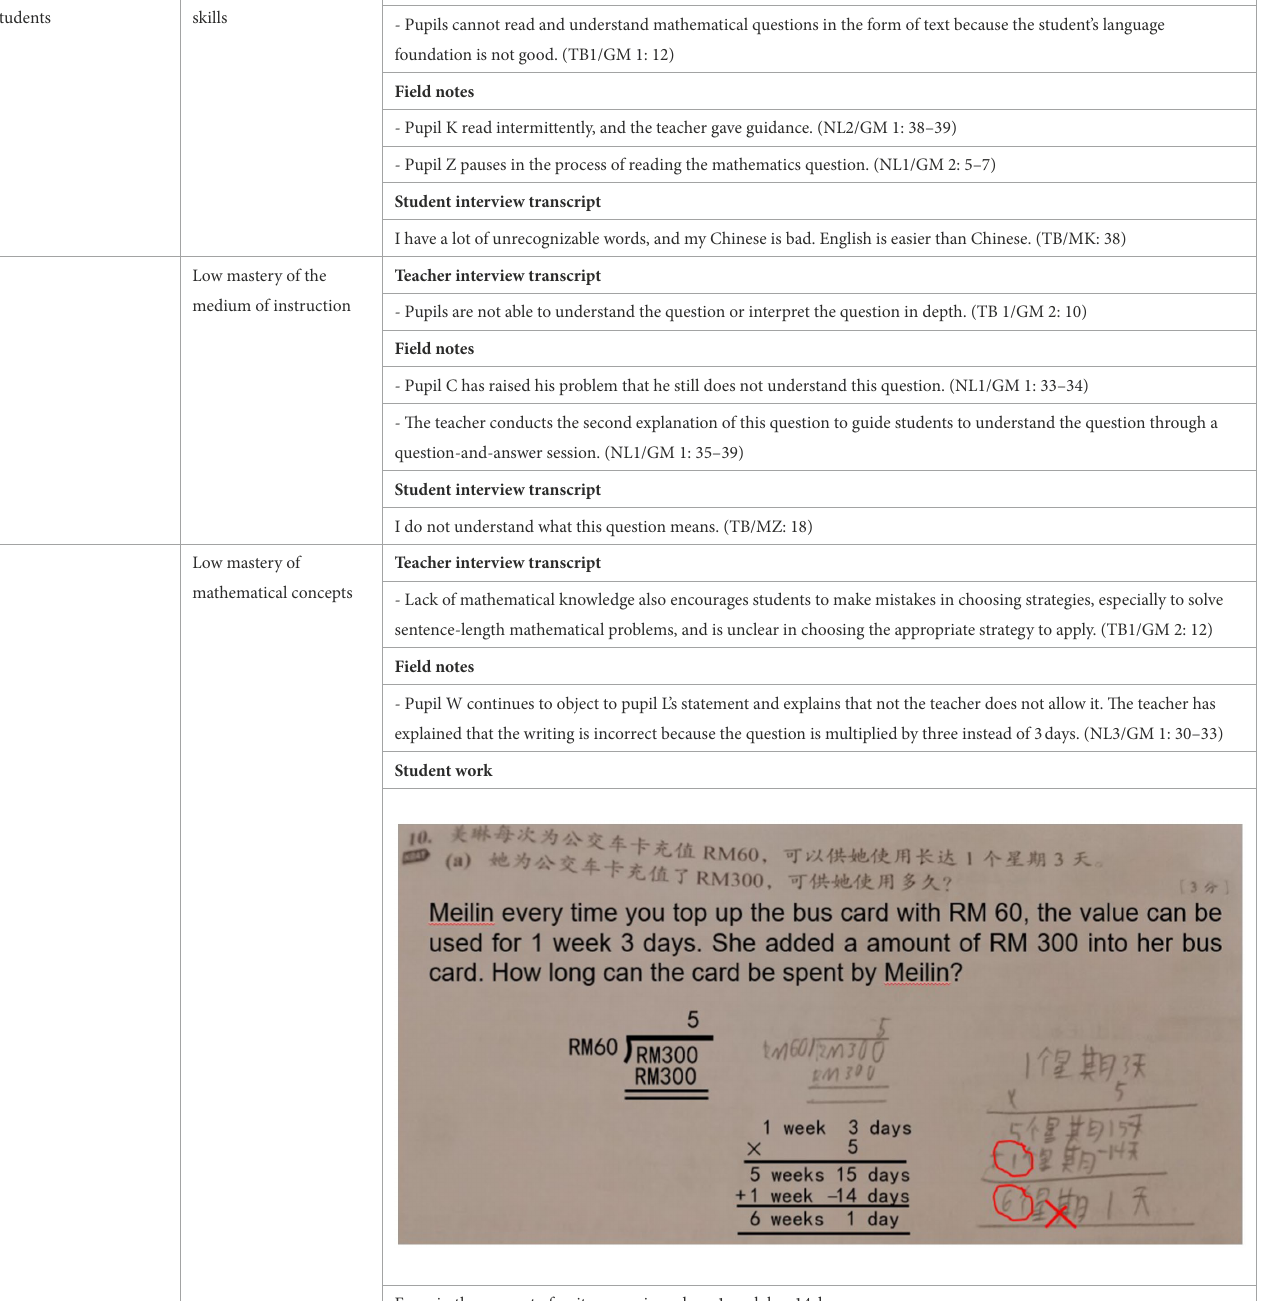
TABLE 1 Teacher challenges when teaching sentence-based mathematics problem-solving skills. Theme Subtheme Evidence Low mastery skills in the